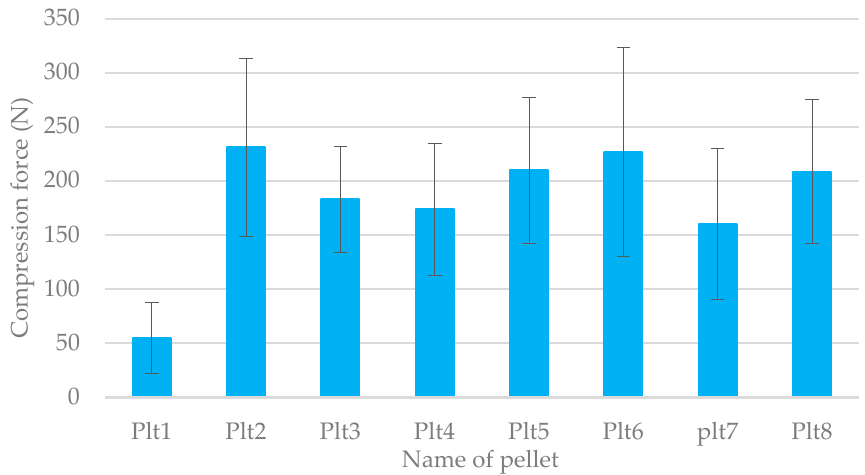
Figure 7. Comparison of the hardness of the eight pellet types.